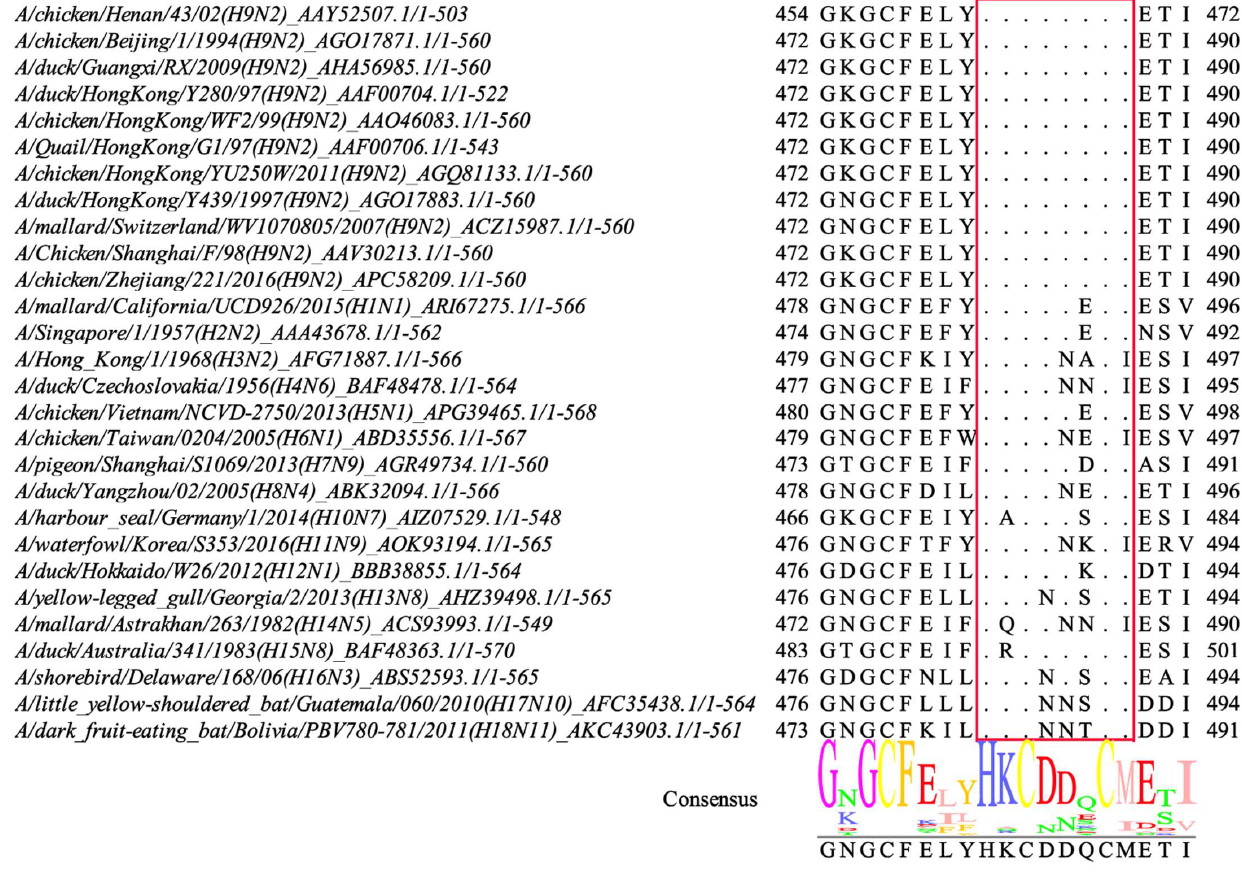
Figure 6. The conservation analysis of the identified epitope. Multiple sequence alignment of the identified epitope in 11 different strains of H9N2 AIV and H1-H18 AIV subtypes. The amino acid sequences of the novel identified epitope in different strains were highlighted with a red line.